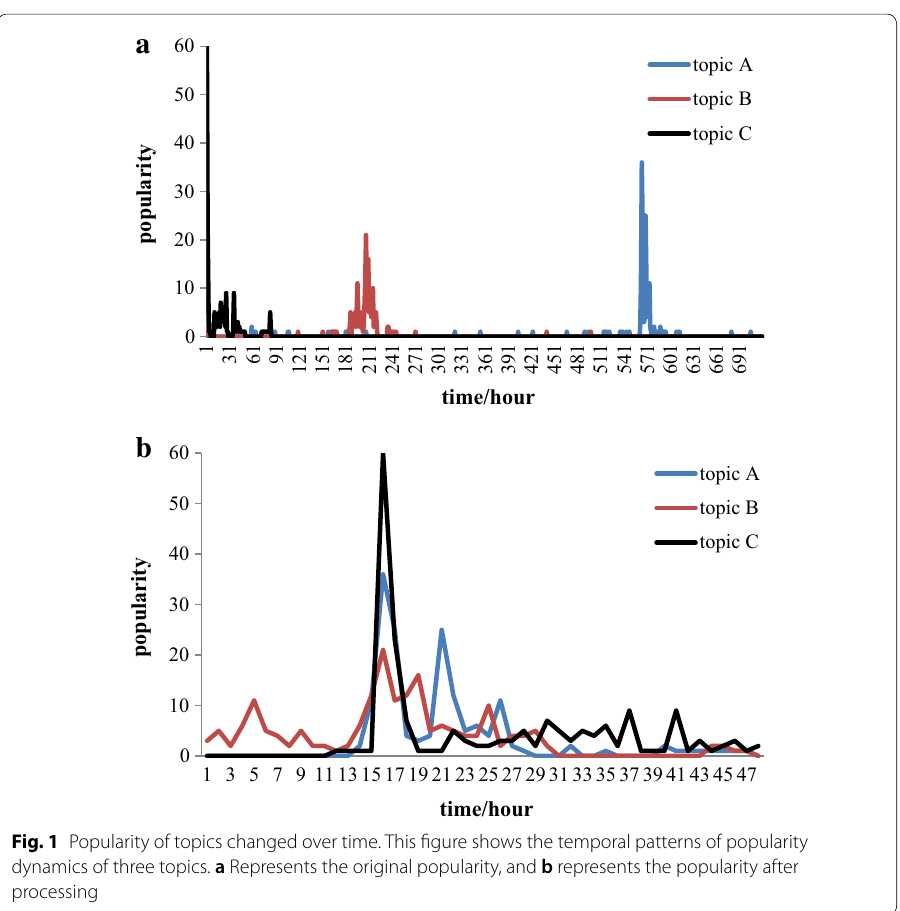
Fig. 1 Popularity of topics changed over time. This figure shows the temporal patterns of popularity dynamics of three topics. a Represents the original popularity, and b represents the popularity after processing